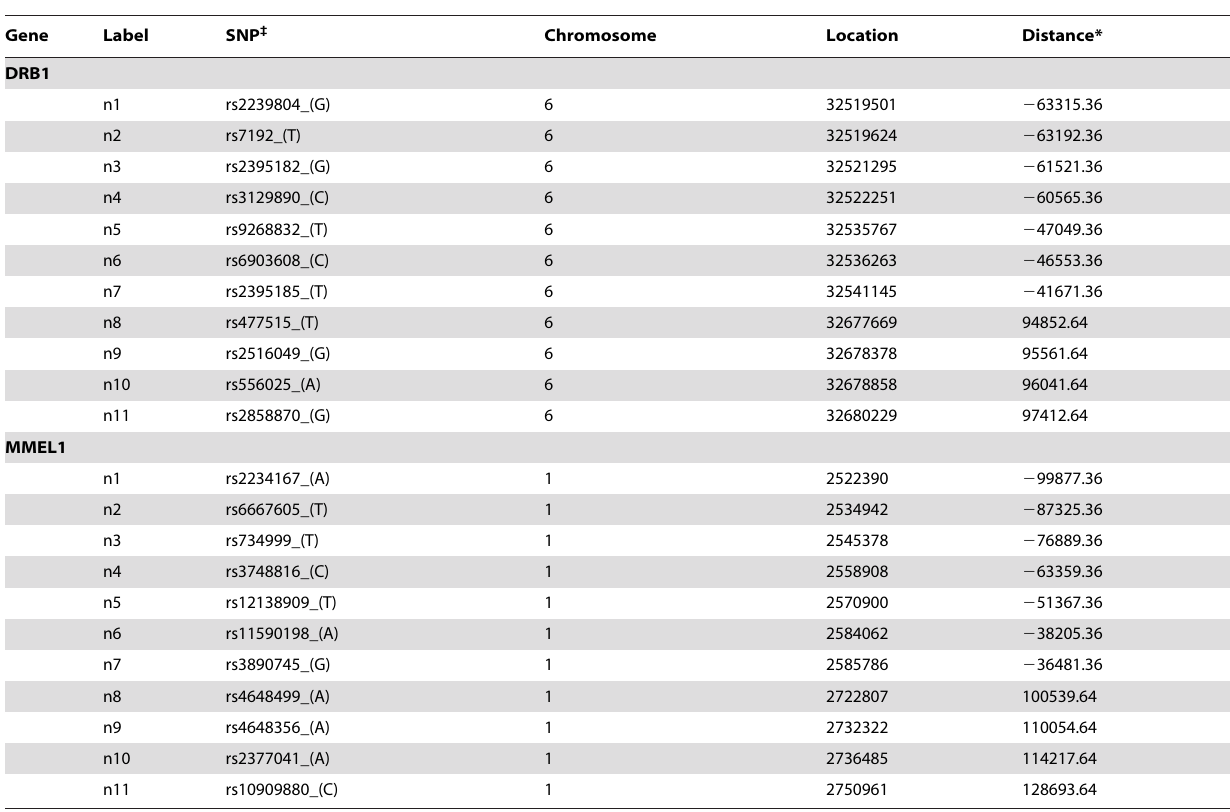
Table 1. SNPs used for the SNP-String Analysis.